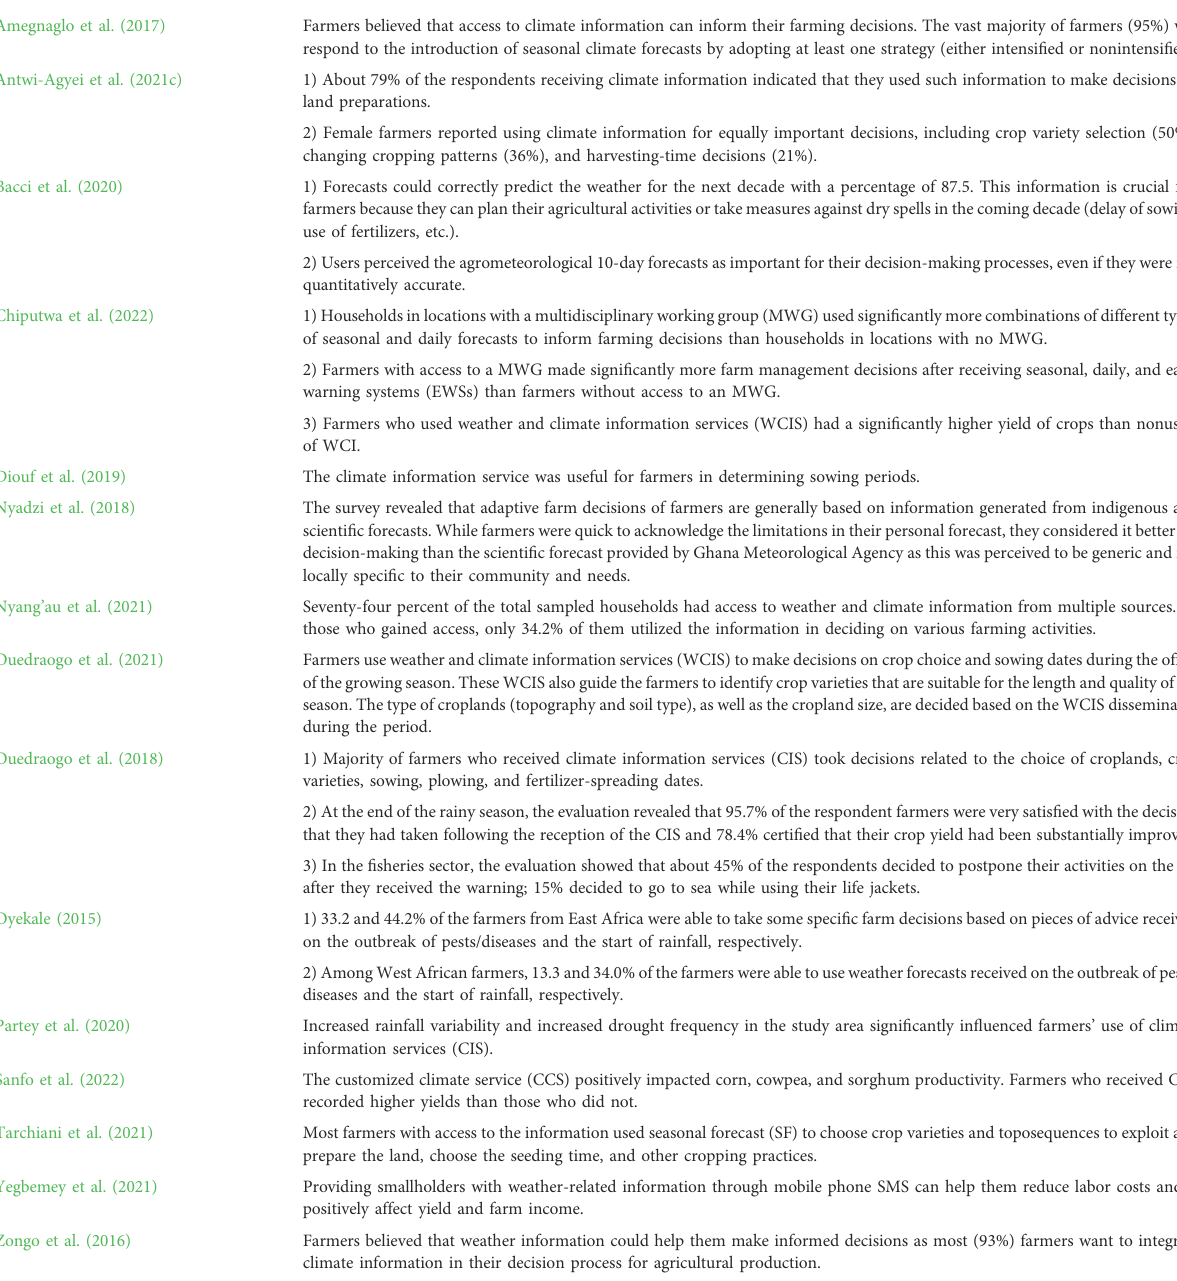
TABLE 3 Summary of decisions made by users after accessing weather